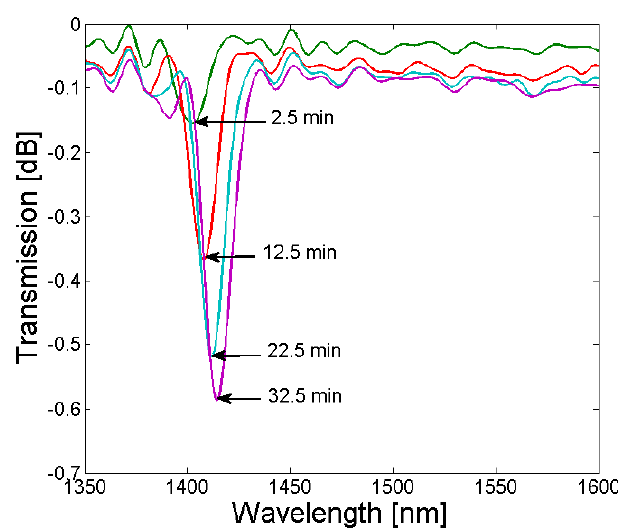
Figure 11. Gradual growth of the absorption dip with increasing UV exposure time, recorded during inscription of an LPG with a grating period of 365 μ m in the SM1500 fiber taper, with a starting diameter of 80 μ m, and applying a pulse energy of 7 mJ and a repetition rate of 80 Hz.